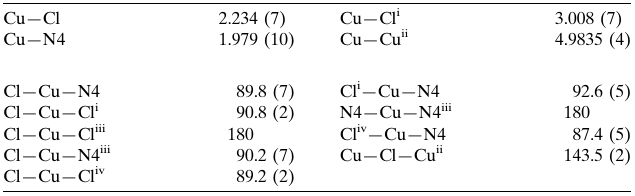
Selected geometric parameters (A˚ , (cid:2) ).